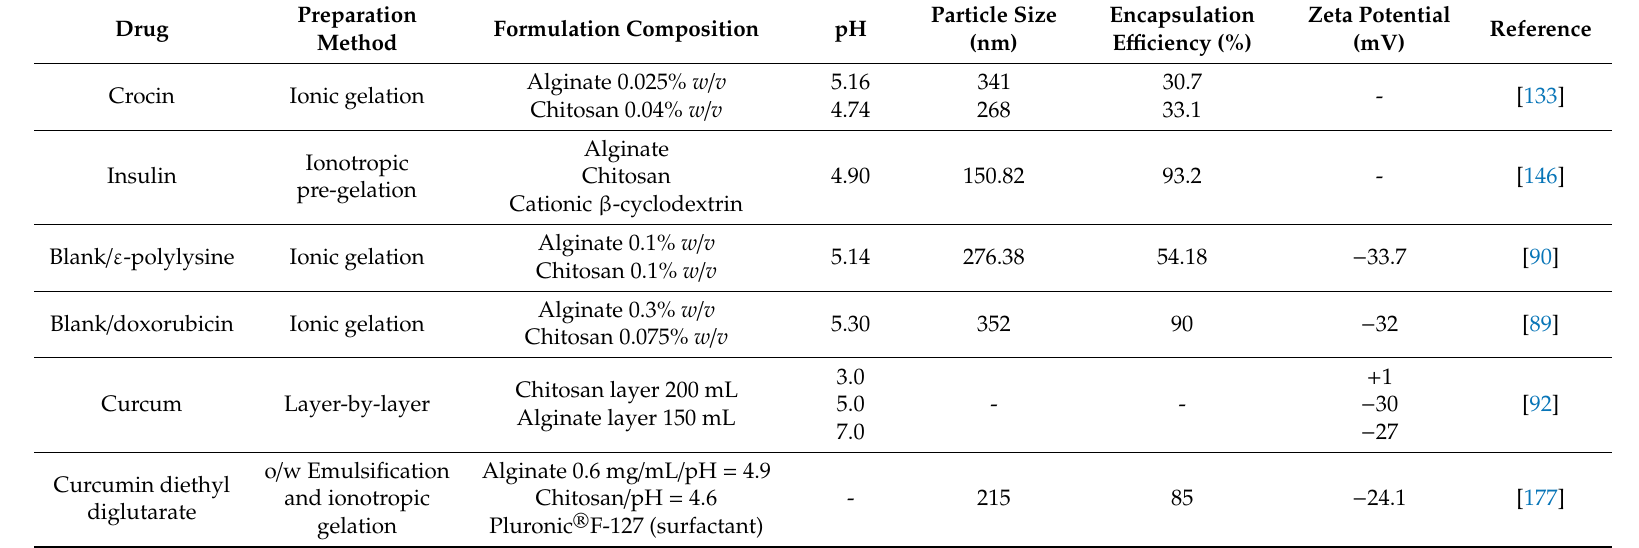
Table 6. The influence of pH on the prepared alginate